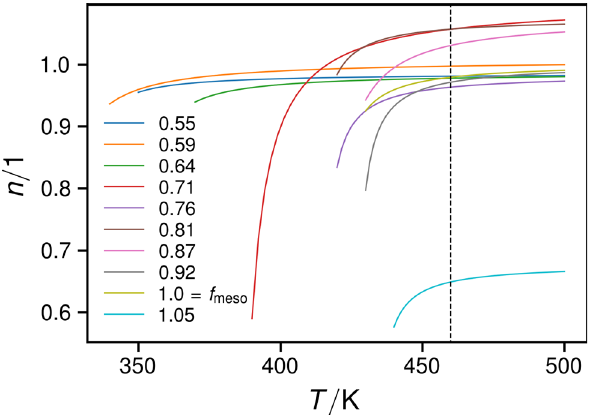
Figure 8: Doolittle exponential progression parameters B ( squares meso and full lines ) and scaling parameters to the shear thinning e ff ect C ( circles and dashed lines )